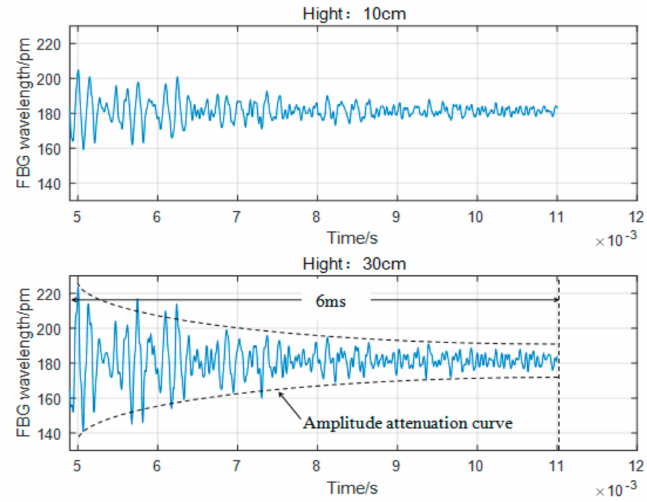
Figure 7. 10 cm and 30 cm time-domain characteristic